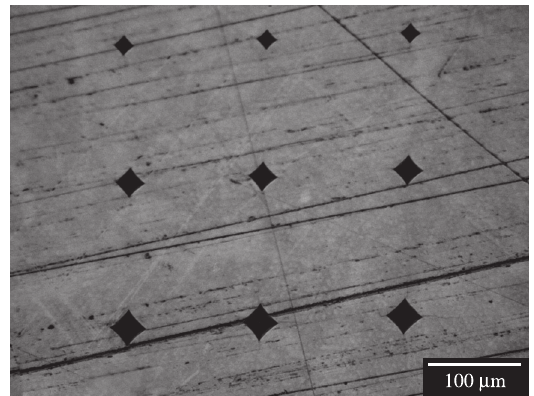
Figure 1. Group of Vickers indentations on enamel at different loads and times.